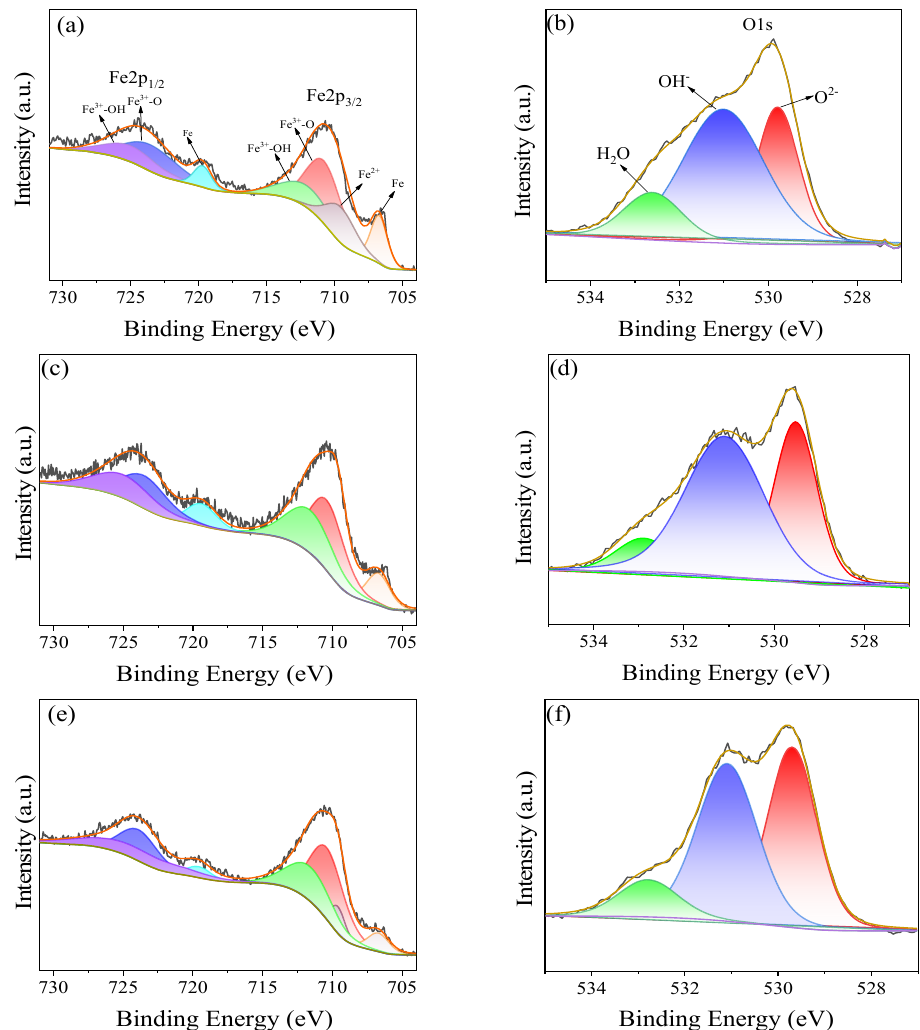
Figure 3. Characteristics of passive film on the surface at different temperatures: ( a , c , e ) are the XPS diagram of iron, and ( b , d , f ) are the XPS diagram of oxygen.